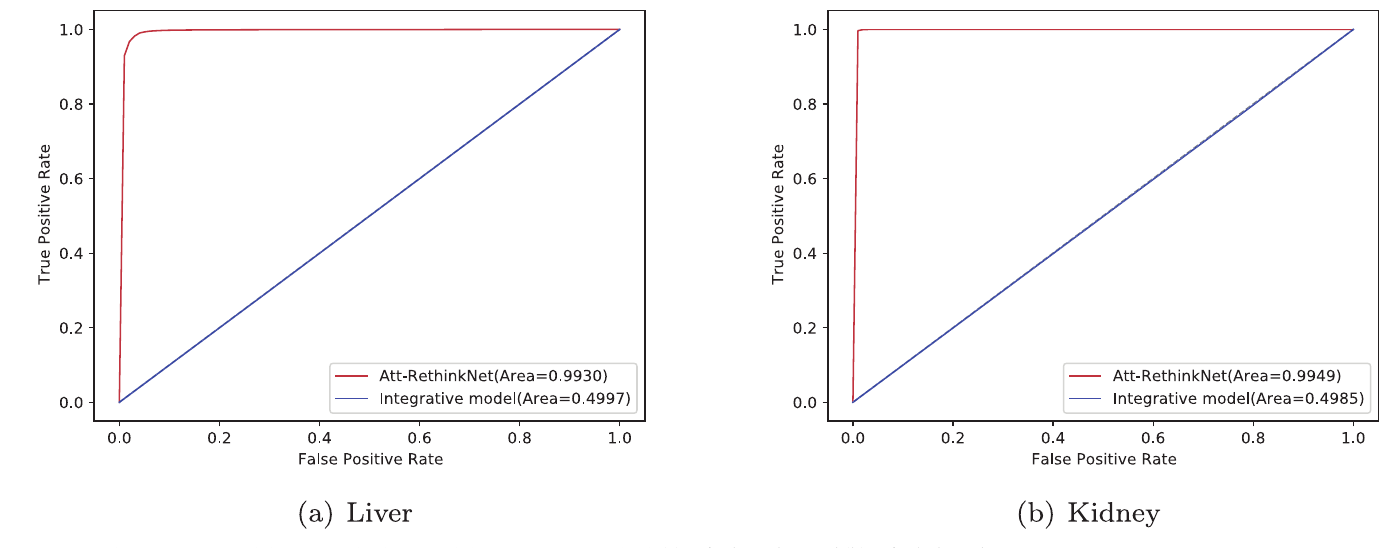
Fig 13. The ROC curves of the Att-RethinkNet and the integrative method. (a) is for liver data and (b) is for kidney data.